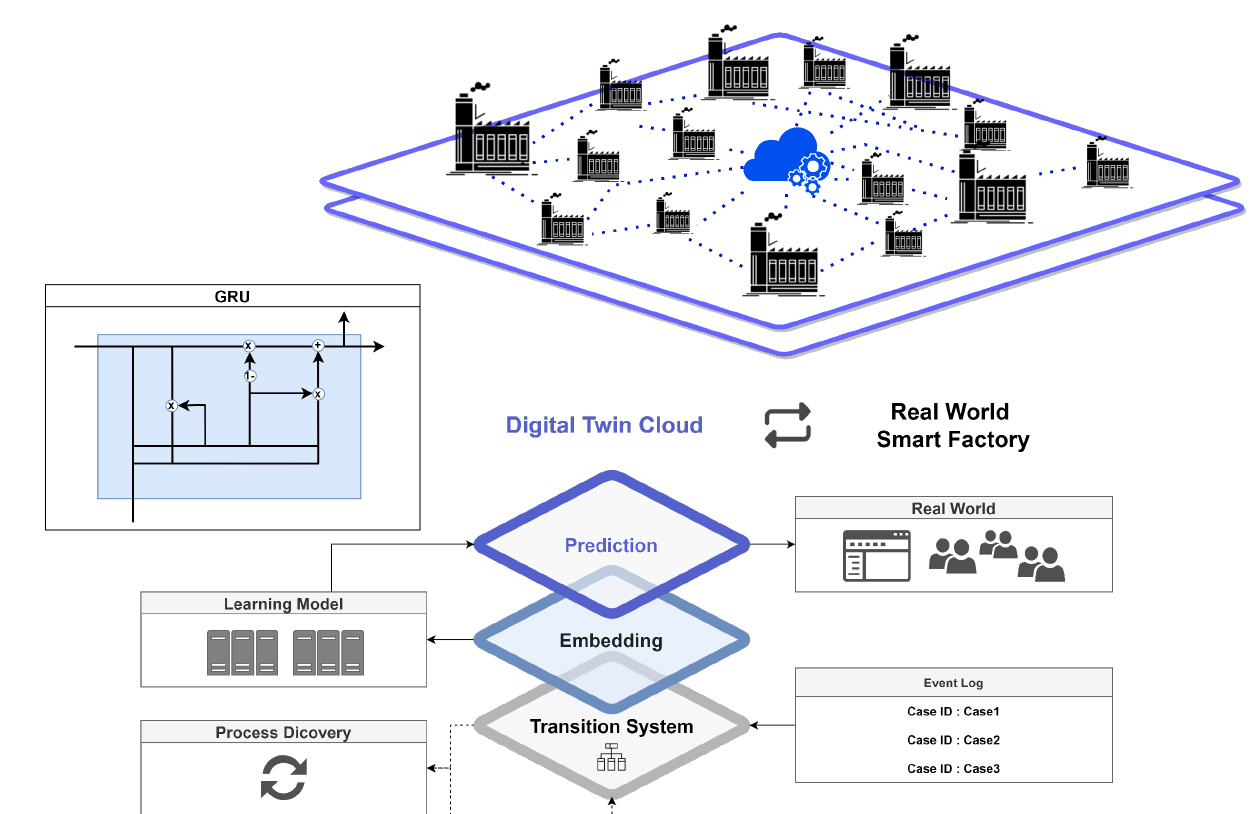
Figure 2. Collaborative digital twin framework for smart